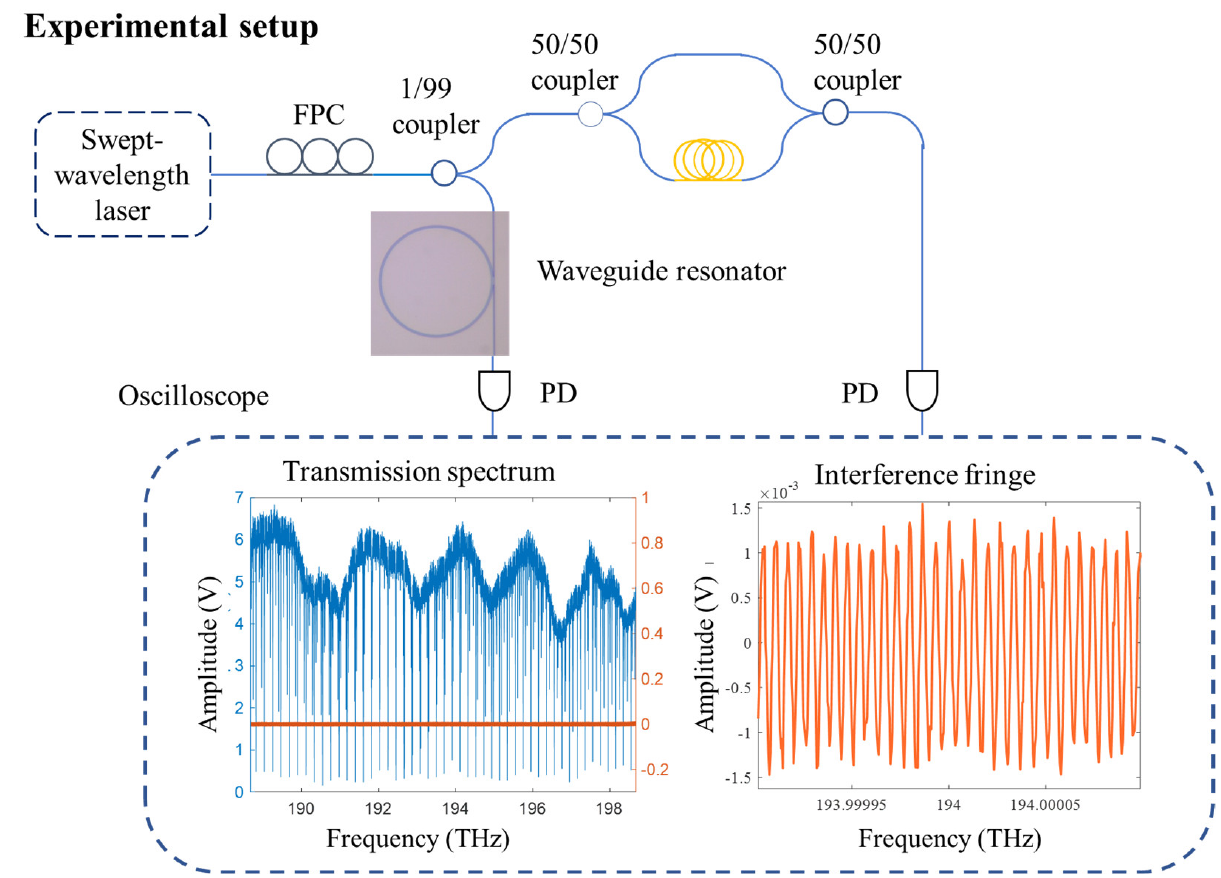
Figure 4. Experimental setup for the dispersion measurement.